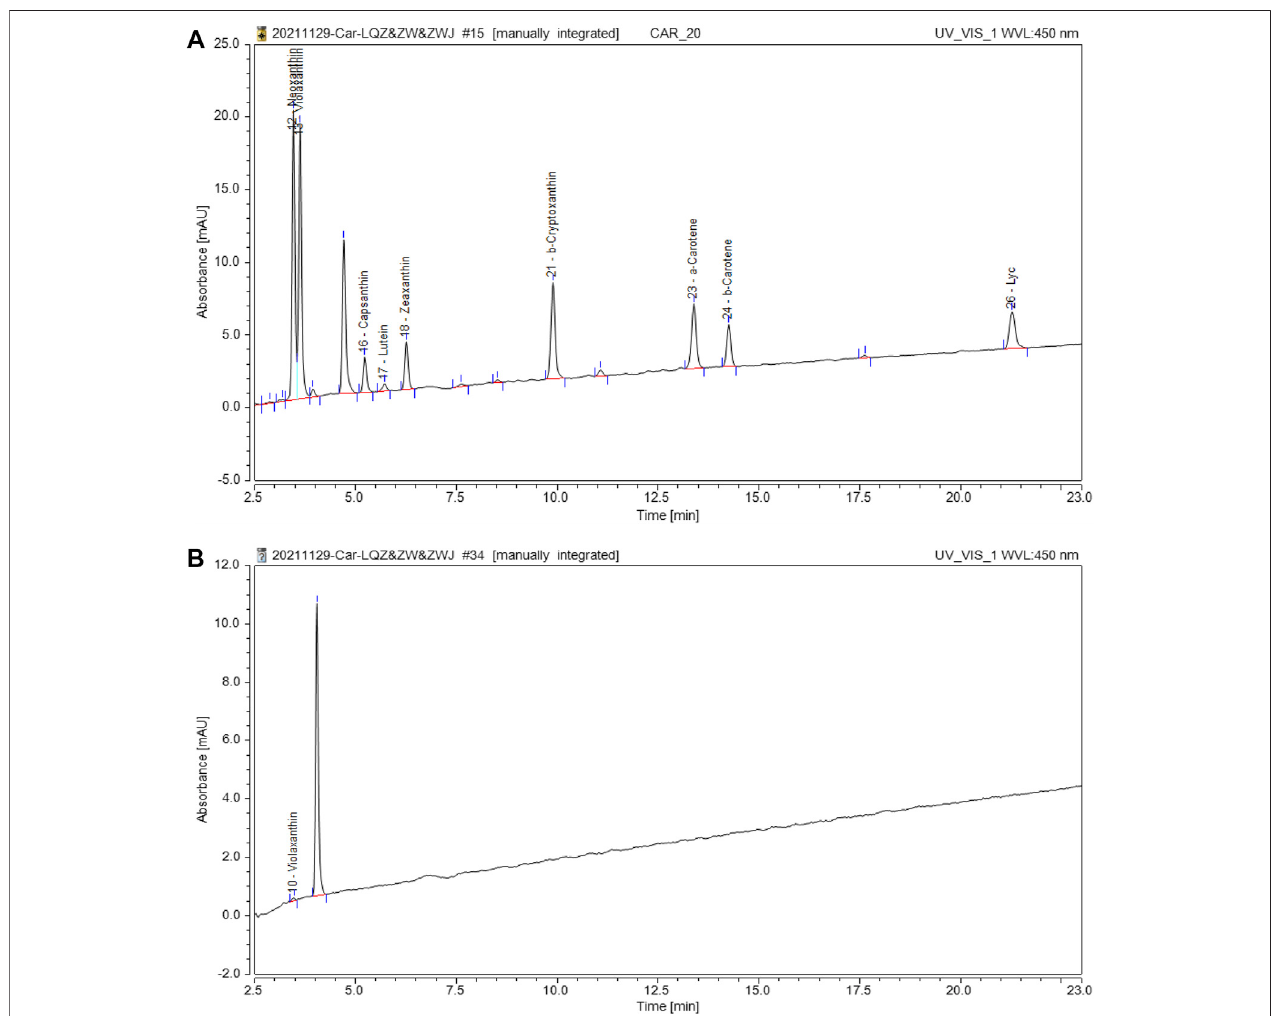
FIGURE 3 | HPLC separation of carotenoids in nacre. (A) : The chromatogram of the carotenoid standard; (B) : The chromatogram of carotenoids in shell nacre sample.